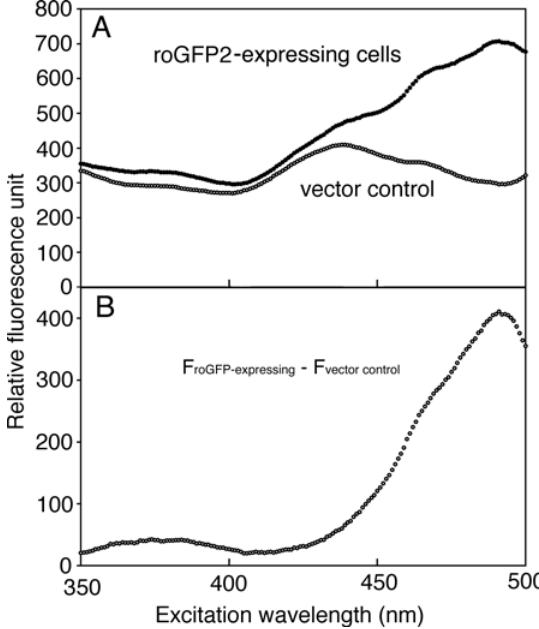
108-114. Appendix Figure 1. Fluorescence of roGFP2 expressed in E.coli cells. (A) fluorescence spectra of roGFP2-expressing cells (filled circle) and vector control (open circle), (B) subtraction of vector control from the roGFP2-expressing spectrum. Each data point was obtained within a 1 nm interval. The data presented shows the results from a single typical experiment of 3